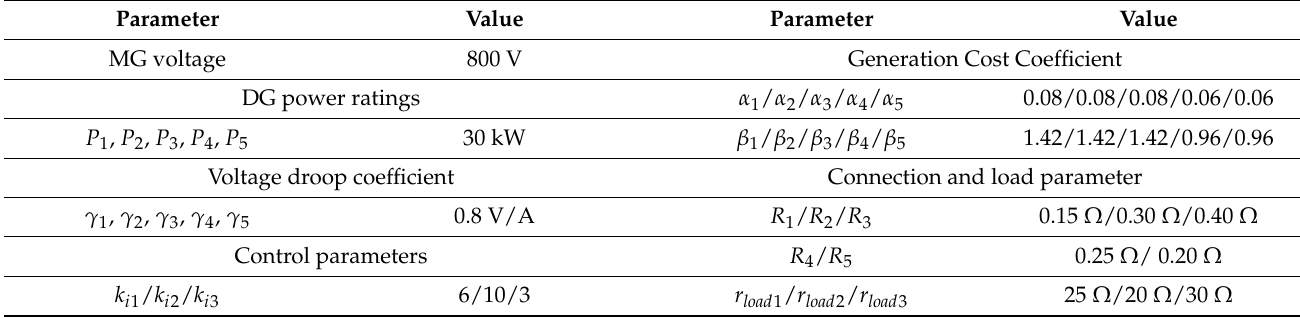
Figure 5. Configuration of the test MG. Table 1. Network and control parameters. Table 1. Network and control parameters.